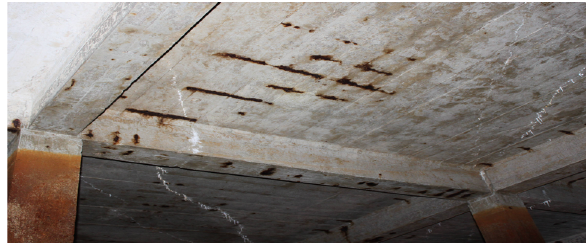
Figure 7: The exemplifying crack with stalactites of salting out in the roof slab.